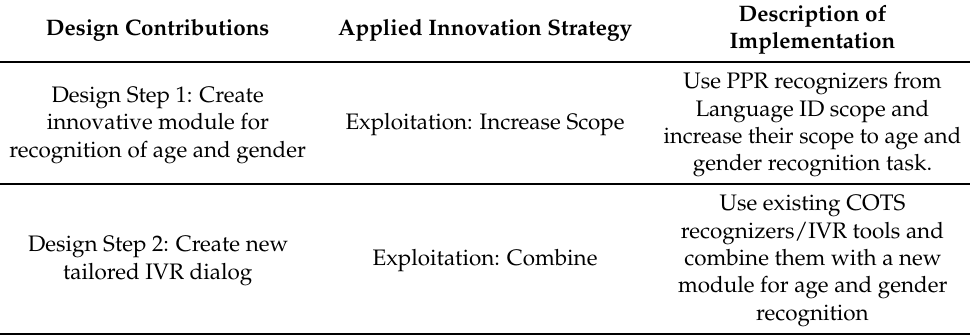
Table 3. Research Design for Case Study, applying the IISF strategies from Figure